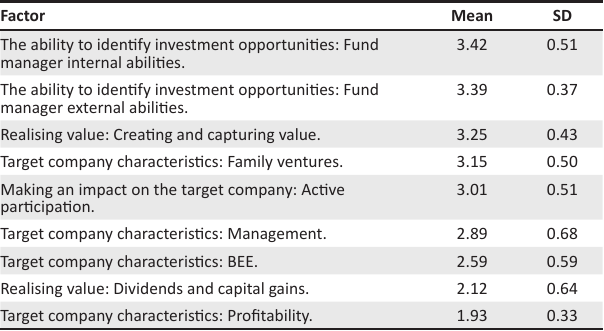
TABLE 3 : Descriptive statistics of factors. Factor Mean